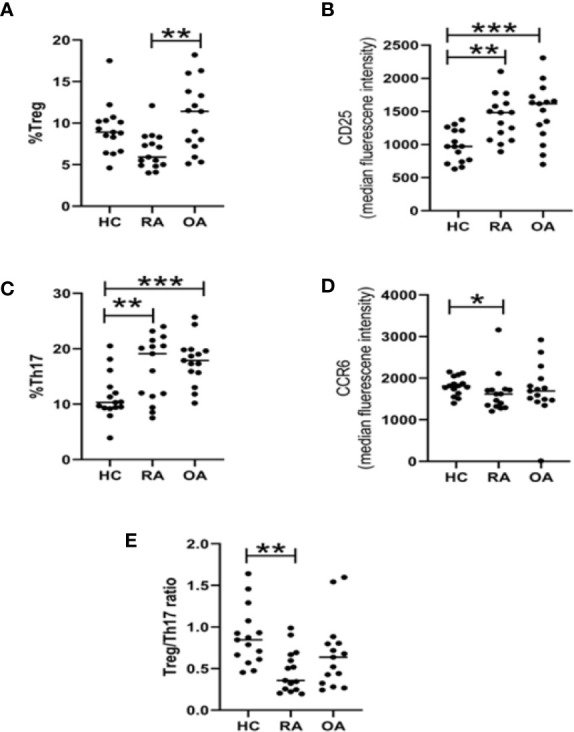
Flow cytometry analysis of Treg and Th17 lymphocyte subpopulations in HC (n = 15), RA (n = 15), and OA (n = 15) blood. Percentage of Tregs cells among CD4 cells (A). Expression of CD25 on Tregs (B). Percentage of Th17 cells among CD4 cells (C). Expression of CCR6 on Th17 (D). Treg/Th17 ratio (E). *p < 0.05, **p < 0.005, ***p < 0.0005.